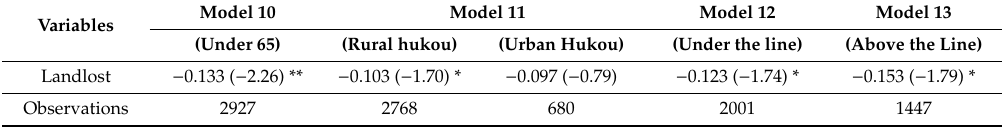
Table 6. Robustness of estimating health status: changes in the sample